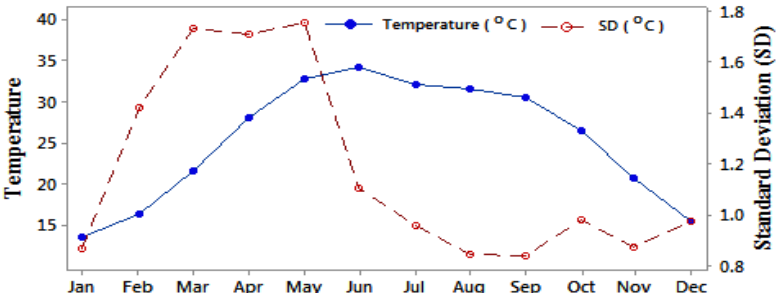
Figure 3. Series of the standard deviation of the mean monthly temperature of Lahore district within 1970–2012.